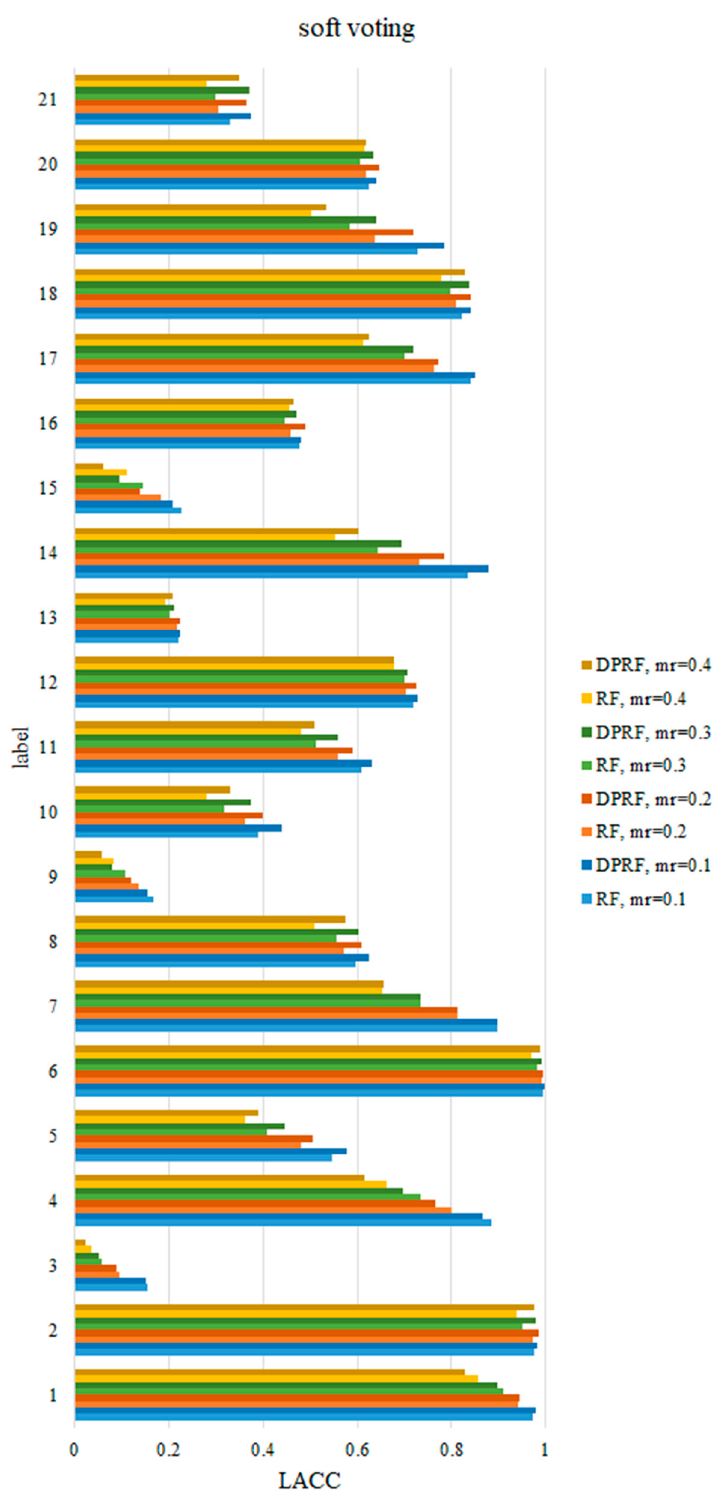
Figure 6. Comparison of LACC of RF and DPRF at different missing rates based on soft voting. Table 6. Summary of LACC of RF and DPRF based on soft voting rules. Missing Rate